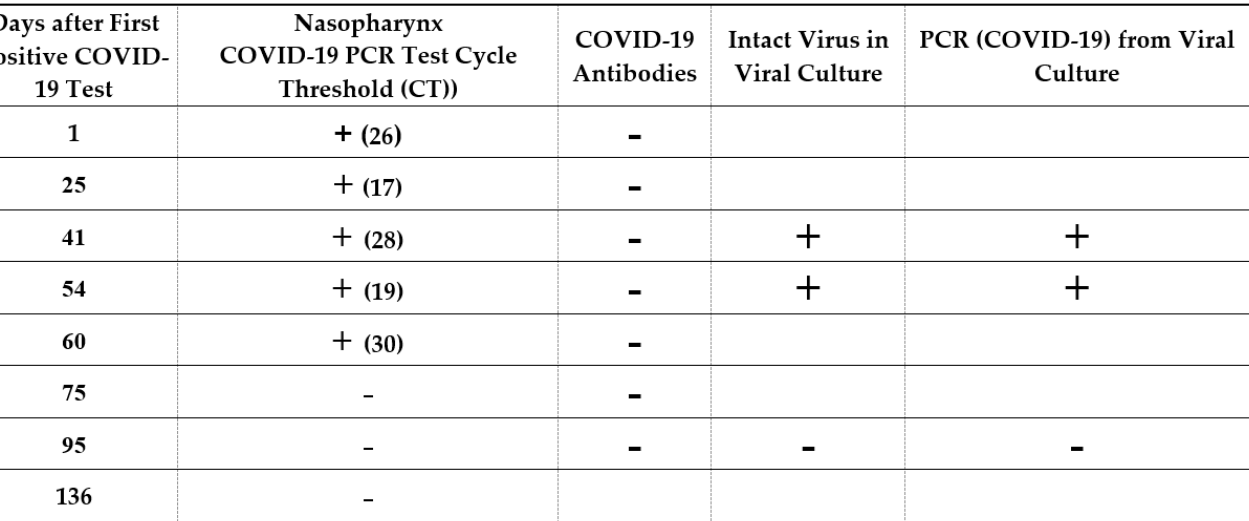
Figure 3. COVID-19 infection and immunity status as detected by nasopharynx COVID-19 PCR tests and viral culture. A PCR test of nasal and throat samples showed positive test on days 1, 25, 41, 54 and 60 with a low cycle threshold (CT). Negative results were visible on days 75, 95 and 136. Cell cultures showed intact viruses on days 41 and 54. Negative cell culture for the corona virus was verified on day 95 after the completed course of the treatment.